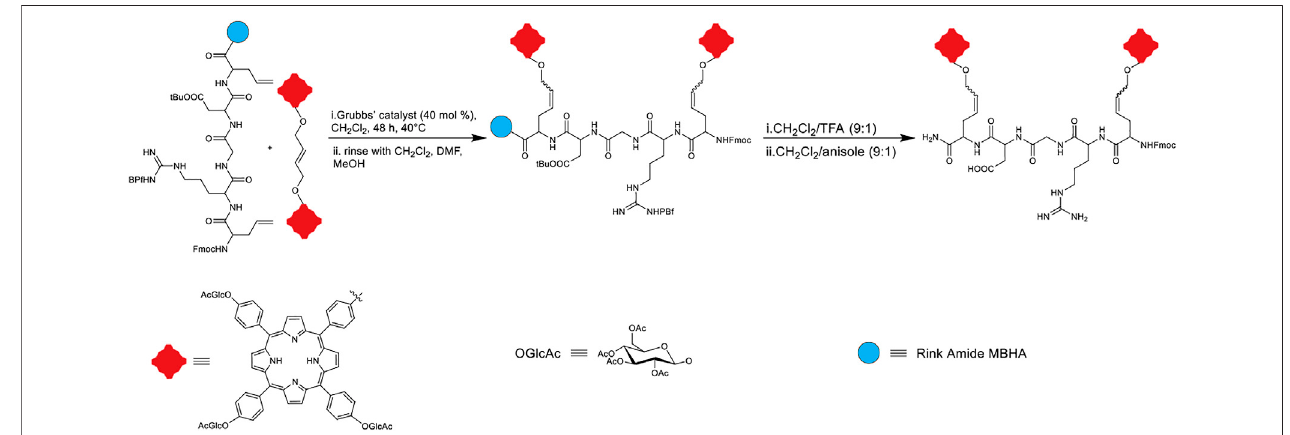
FIGURE 8 | Schematic representation of dimeric porphyrin and peptidic moiety conjugation through ole fi n cross-metathesis (Sol et al., 2008).